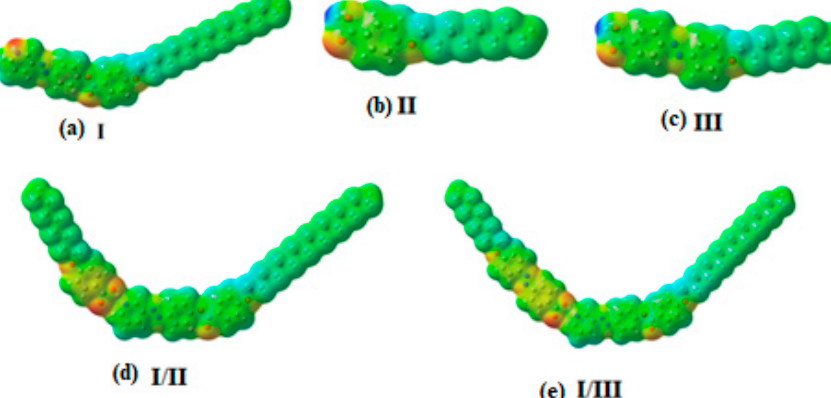
Figure 5. Molecular electrostatic potentials (MEP) of ( a ) base I , acids ( b ) II and ( c ) III and their supramolecular complexes ( d ) I/II and ( e ) I/III ; High negatively charged atomic sites ( the red region ); low negatively charged atomic sites ( the blue region ).